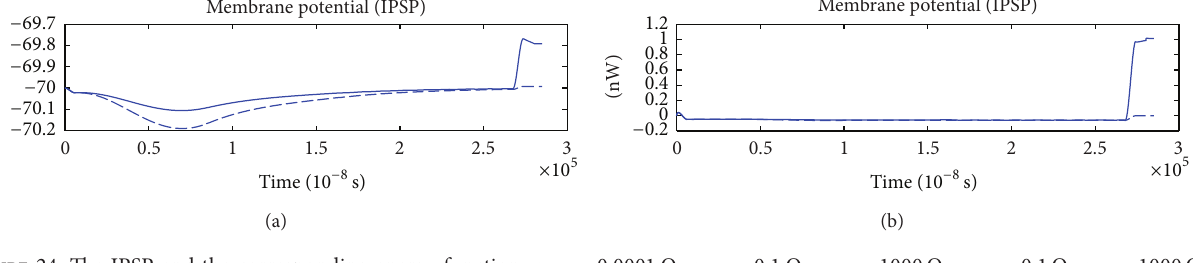
Figure 24: The IPSP and the corresponding energy function. 𝑟 0𝑚 = 0.0001 Ω , 𝑟 1𝑚 = 0.1Ω , 𝑟 2𝑚 = 1000 Ω , 𝑟 3𝑚 = 0.1 Ω , 𝑟 𝑚 = 1000 Ω , = 1 𝜇 F, 𝐿 = 50 𝜇 H, 𝑖 = −0.7 𝜇 A, and 𝑄 = 3 × 10 −7 𝜇 A. 𝐶 𝑚 𝑚 0𝑚